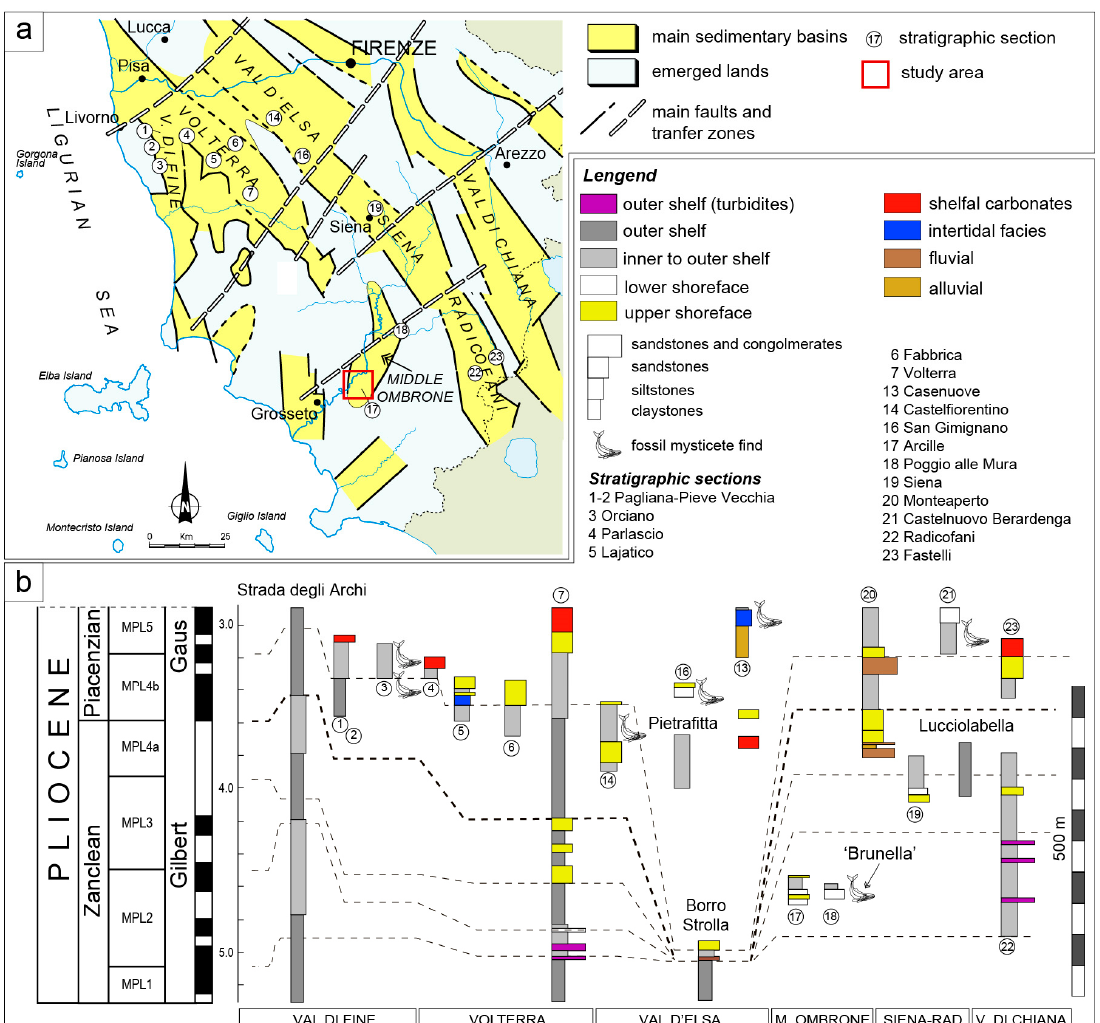
Figure 1. ( a ) Simplified geological sketch showing the Plio-Quaternary basins of Tuscany (modified, after [14]). ( b ) Stratigraphic scheme based on biostratigraphic correlation of selected sections (see geological sketch for location and legend for section names) from the marine Pliocene of Tuscany (modified, after [1]) with occurrence of fossil mysticetes from [1].